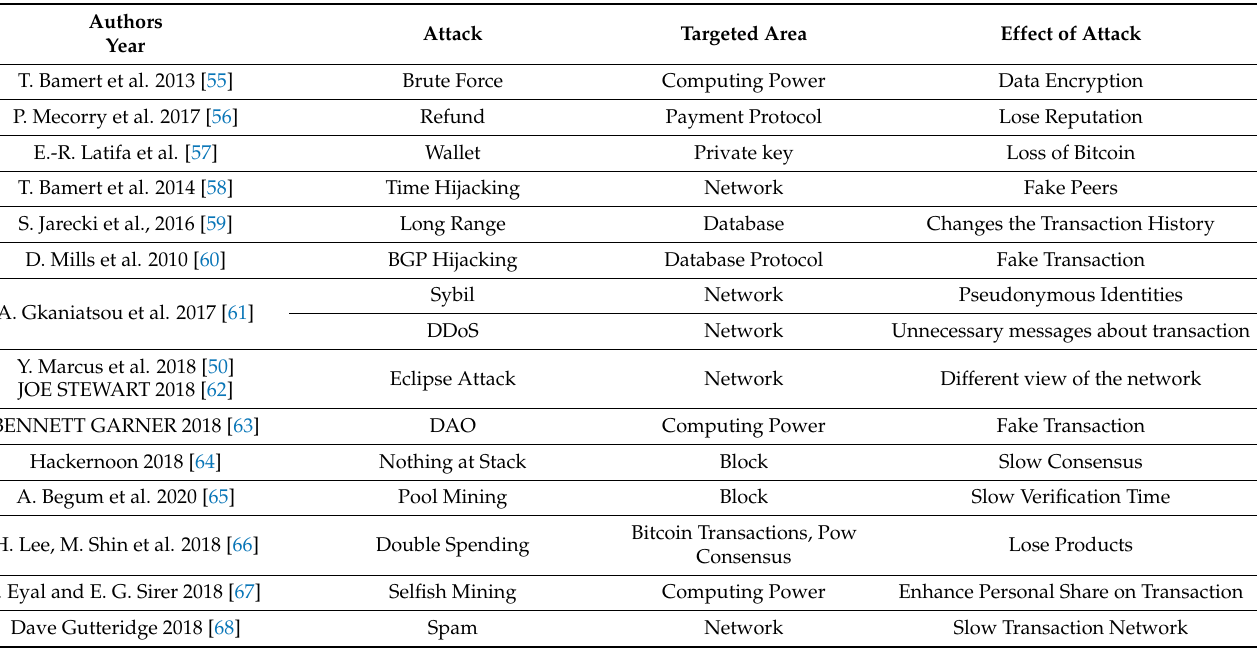
Table 4. Attacks and their targeted areas and effect.